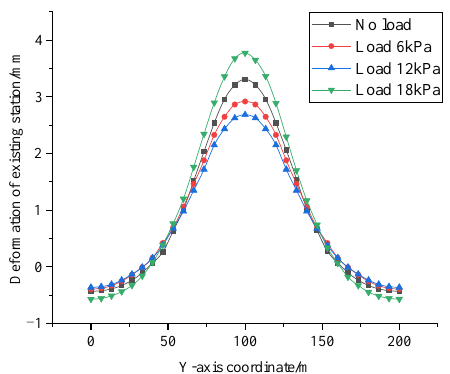
Figure 9. Deformation curve of station under different loads.